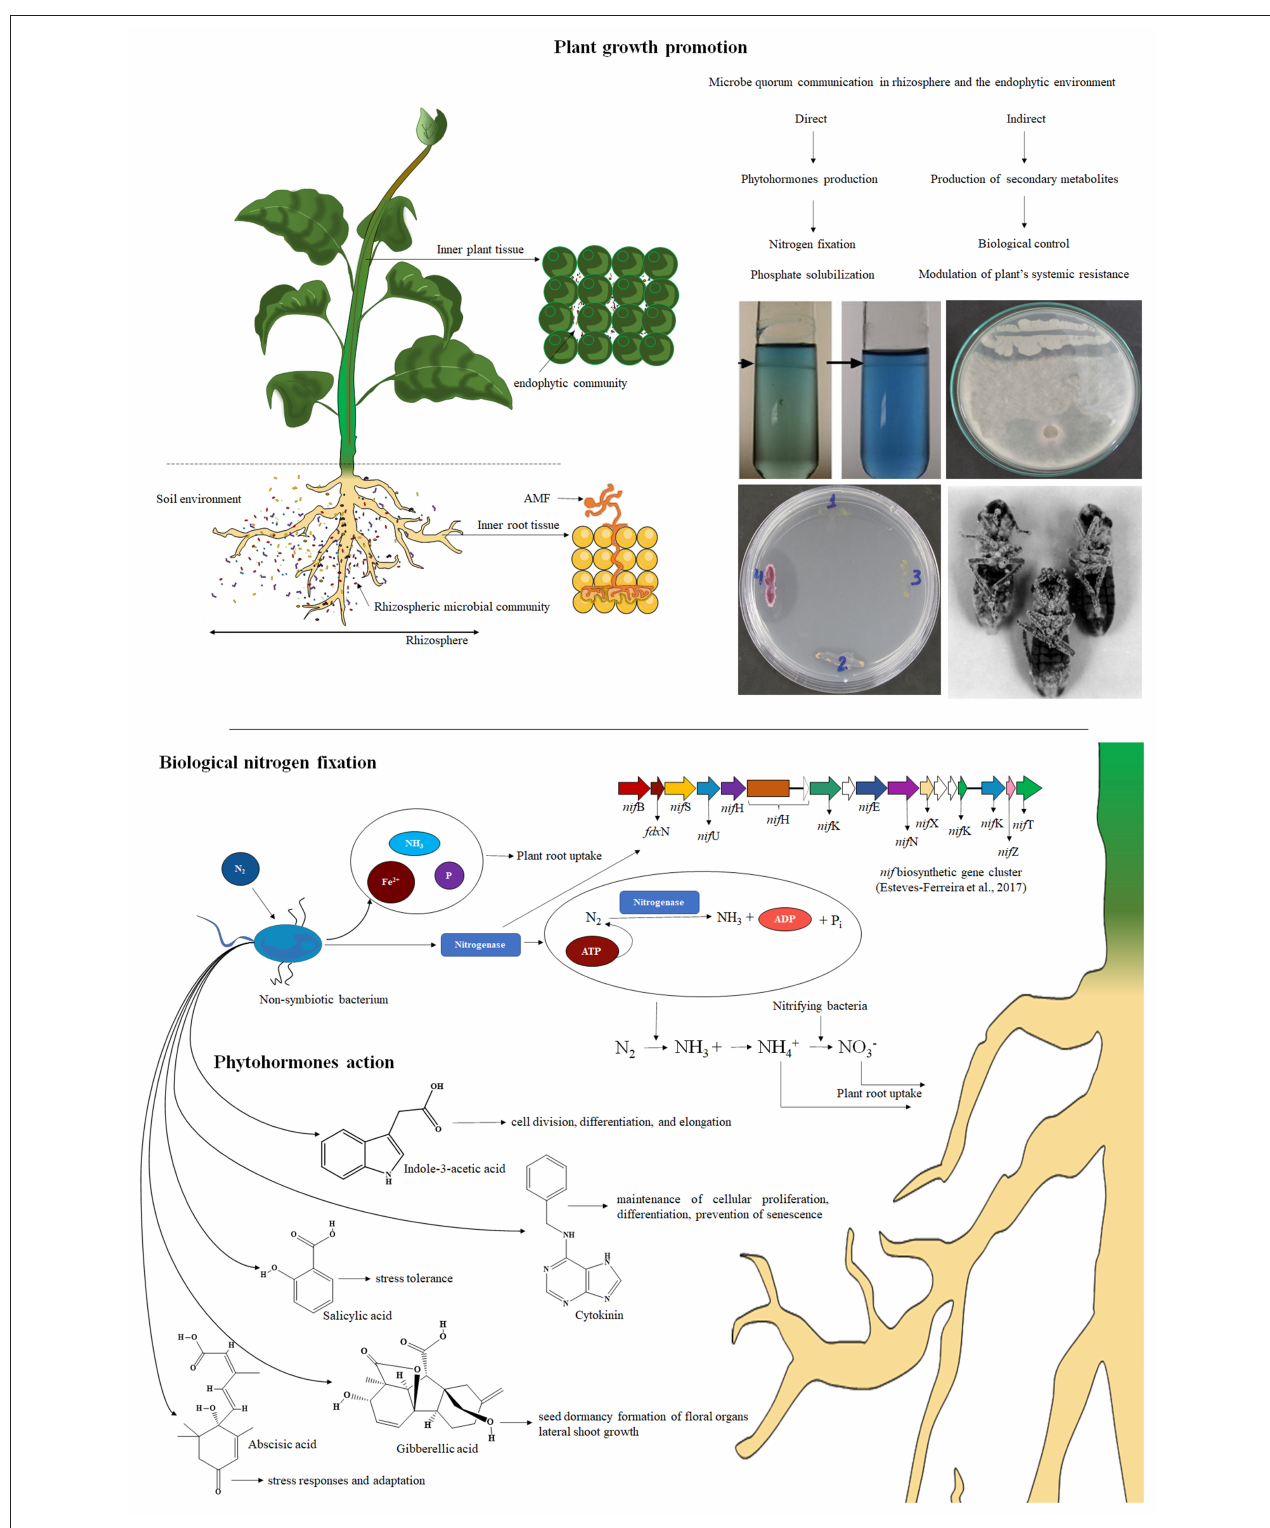
FIGURE 1 | The rhizosphere is a dynamic and complex habitat of innumerable microbes and invertebrates that are attracted by nutrients, exudates, border cells, and mucilage released by plant roots. Thus, symbiotic PGPR indirectly/directly regulates the composition and biomass of the plant microcommunity in natural ecosystems. Indirect mechanisms might occur during competition for nutrients, where PGPR suppresses the effects of pathogens by the production of antibiotics, siderophores, and lytic enzymes, whereas nitrogen fixation, phosphate biodisponibilization, and phytohormone production directly affect plant growth.